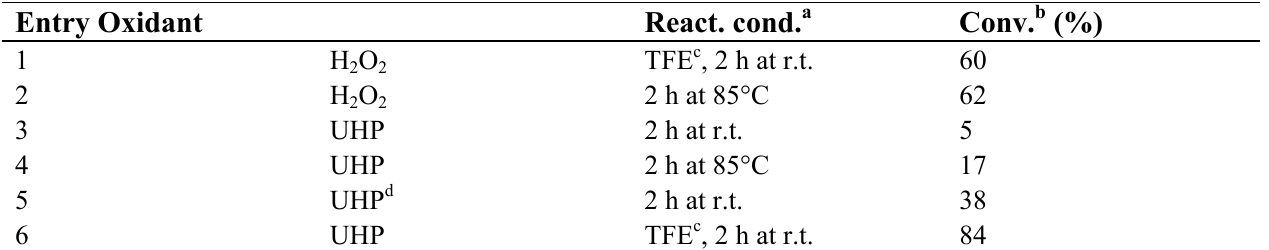
Table 3. Oxidative chlorination of cyclooctene ( 16